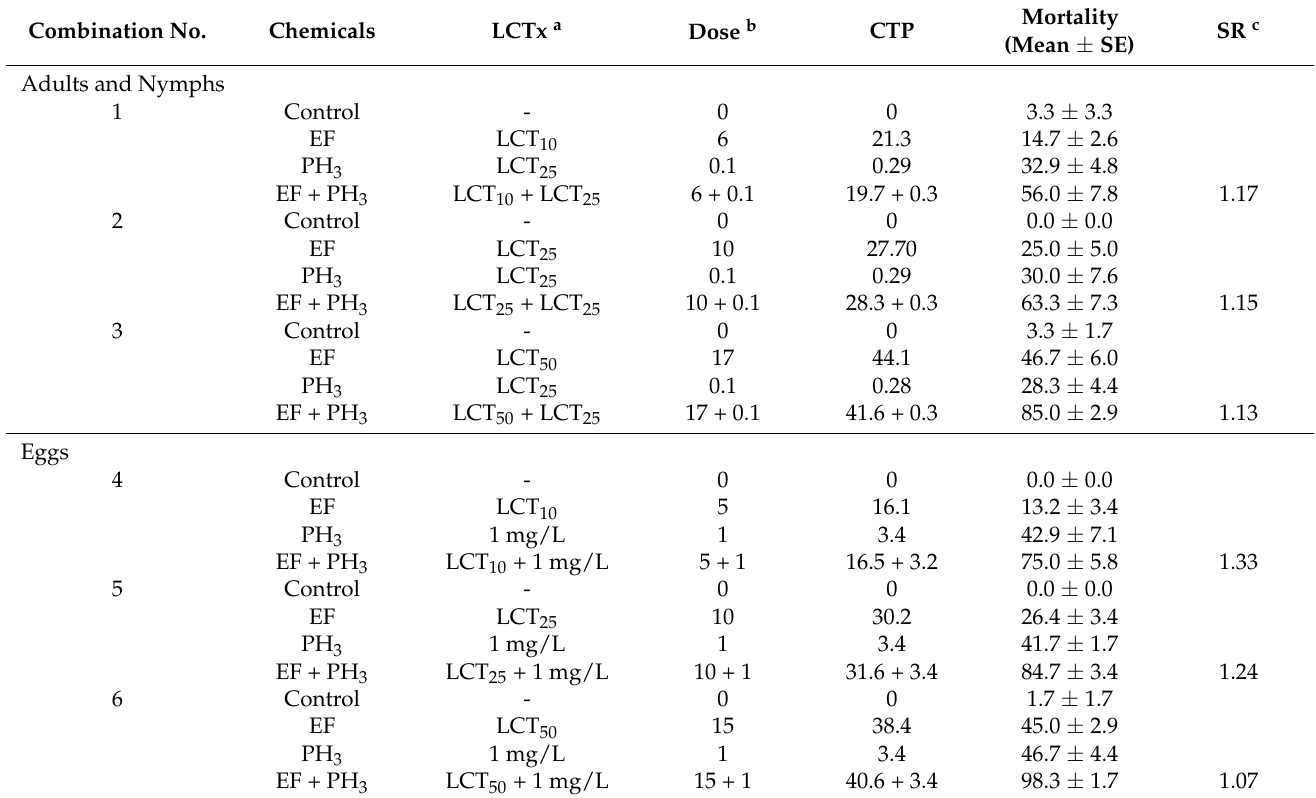
Table 2. Evaluation of synergistic effects with different combinations of ethyl formate (EF) and phosphine (PH 3 ) on P. citri adults, nymphs, and eggs under 4 h exposure at 20 ◦ C ( n = 20, triplicate). Combination